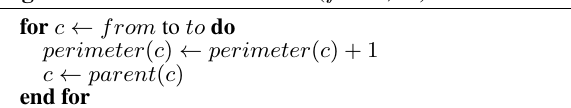
Algorithm 2 increasePerimeter ( from , to )